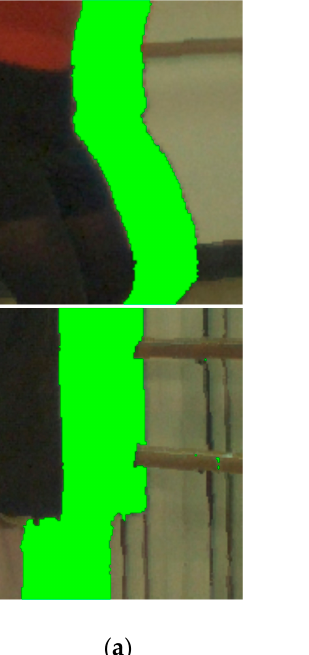
Figure 7. The example of refinement process: ( a ) Original reference image; ( b ) synthesized image without depth image preprocessing; ( c ) reference image with depth value refinement; ( d ) and synthesized image after depth image preprocessing.